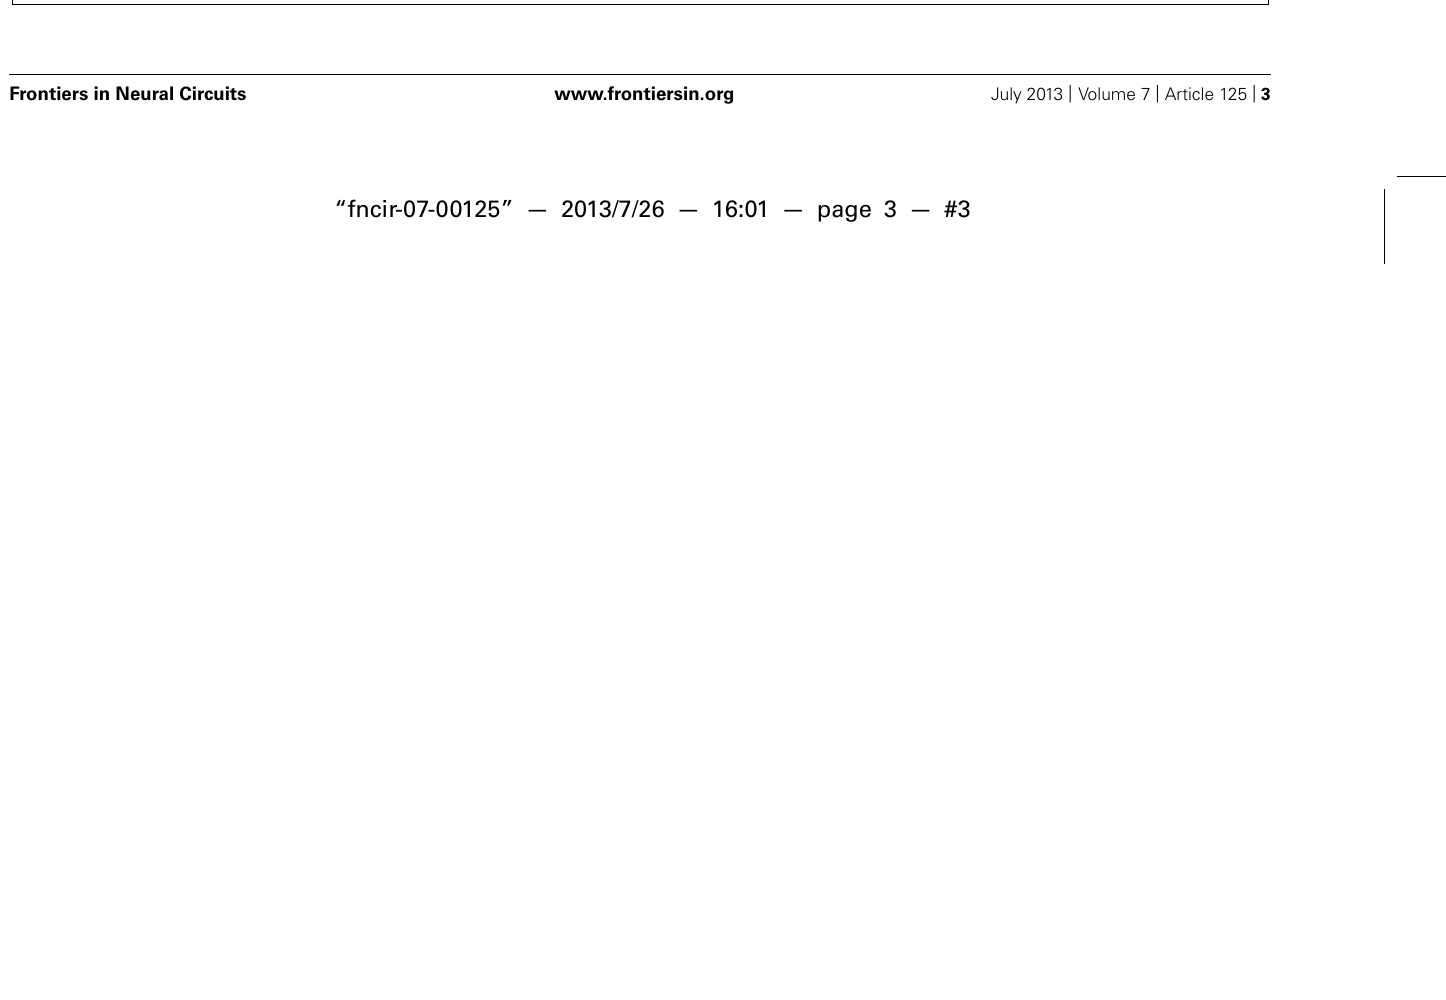
FIGURE 1 |A sample of oscillations recorded from cerebellar cortex in vivo local field potentials (LFPs) using metal microelectrodes. LFP example data located on the left, and corresponding Fast FourierTransform (FFT) spectrum on the right. FFT shown in the form of %. (A) Simultaneous different types of LFP oscillations in the primate rhesus monkey cerebellum. Top: LFP oscillations from the PM GCL, around 19 Hz. Bottom: faster LFP oscillations recorded in the anterior lobe GCL, going up to 40 Hz. Gray shaded area corresponds to the time period for the FFT analysis. Notice the simultaneous co-existence of two different oscillatory phenomena.